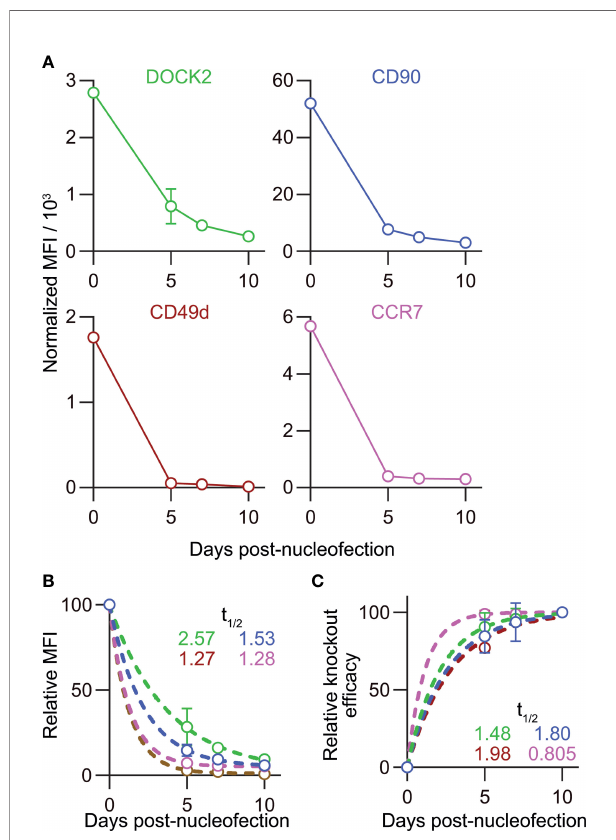
FIGURE 8 | Disparate kinetics of gene inactivation and protein loss for DOCK2, CD90, CD49d/integrin a 4 and CCR7 in naïve CD8 + T cells. (A) Decay of normalized MFI values of target proteins among target lo cells. (B) Relative MFI values of target proteins calculated by normalizing the values presented in (A) to the MFI value on day 0. Curves de fi ned as y = [100 – (Plateau)] × exp( – K × x) were fi tted to the data, with R 2 = 0.979, 0.997, 0.999 and 0.999 for DOCK2, CD90, CCR7 and CD49d, respectively. Plateau values and half-life were computed during curve fi tting. (C) Kinetics of relative knockout ef fi cacy calculated by normalizing %DOCK2-GFP lo and %CD90 lo in each experiment to the corresponding values on day 10. Data were fi tted with the equation y = [Plateau] × (1 – exp( – K×x)], with R 2 = 0.984, 0.970, 0.999 and 0.926 for DOCK2, CD90, CCR7 and CD49d, respectively. Plateau value and half-time to reach the plateau was estimated from the data during curve fi tting. Results of ordinary one-way ANOVA with Dunnett ’ s multiple comparison of differences in half-life shown in (B, C) are summarized in Table 2 . Graphs show pooled data from 3 – 6 independent experiments. Values of %CD90 lo from experiments 5 and 6 (as indicated in Figure 7 ) were excluded in C because of their continuous increase until day 10.